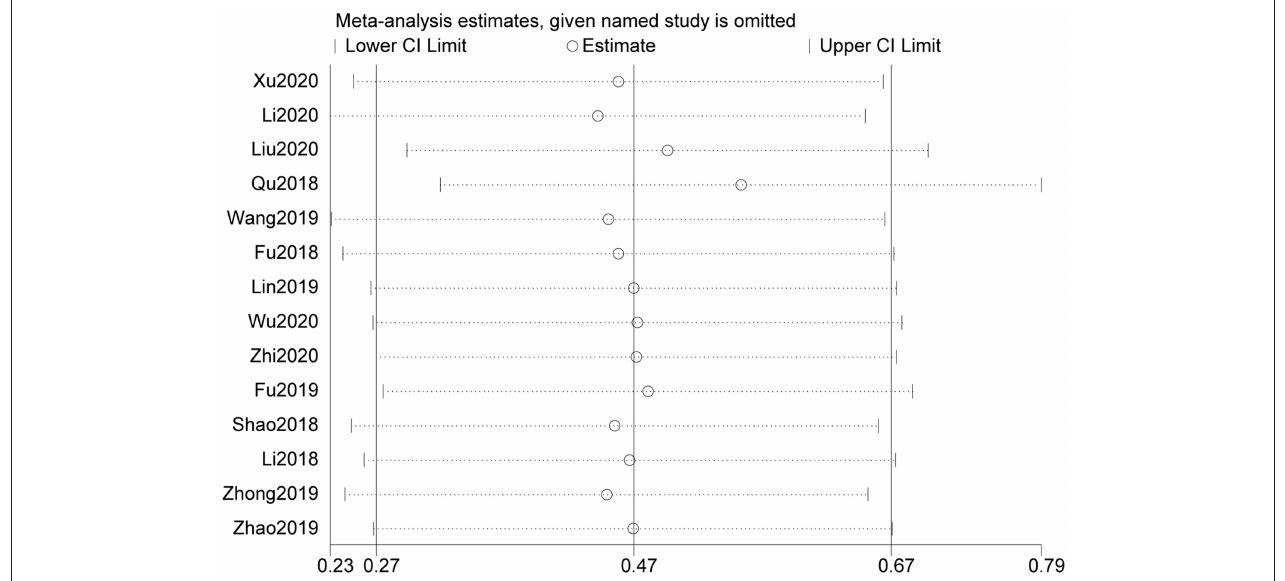
FIGURE 5 | Sensitivity analysis for studies about OS by omitting each study